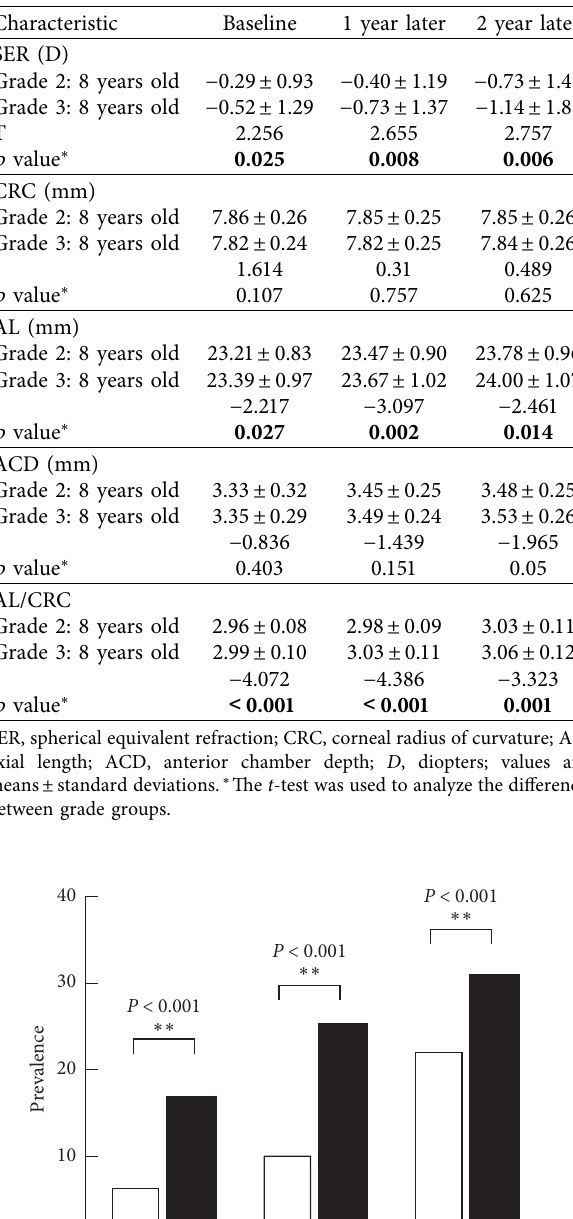
Table 2: Comparison of 2.5-year follow-up characteristics between 332 grade-two and 217 grade-three students who were 8 years old at baseline.